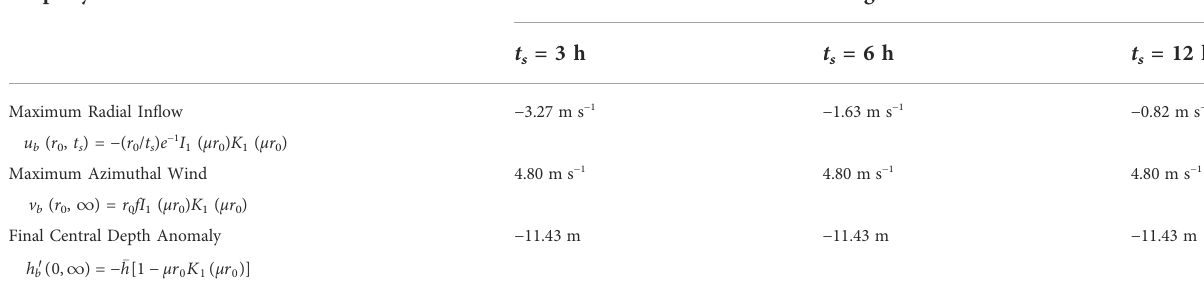
TABLE 2The maximumradial in fl ow,maximum azimuthal wind,and fi nal central depth anomalyfor the threeforcing cases t s =3,6,12h, as computed from the linear balanced solutions (Eq. 15) using the speci fi ed and computed constants listed in Table 1. The maximum radial in fl ow is proportionalto1/ t s ,buttheweakerin fl owslastprogressivelylonger.Sincethesamevolumeof fl uidisremovedineachcase,the fi nalvalues v b ( r 0 , ∞ ) and h b 9 ( 0 , ∞) arethesame.Eventhoughalltheoriginalmassinside r = r 0 hasbeenremovedbythemasssink,almostallofthismasshasbeenreplaced by the time-integrated in fl ow at r = r 0 , so that the fi nal central depth anomaly is only − 11.43 m. Detailed plots of the t s =3 h and t s =6 h cases are presented in Figures 2, 3. The t s =12 h case is not shown since the balanced solutions and the primitive equation solutions are so similar.